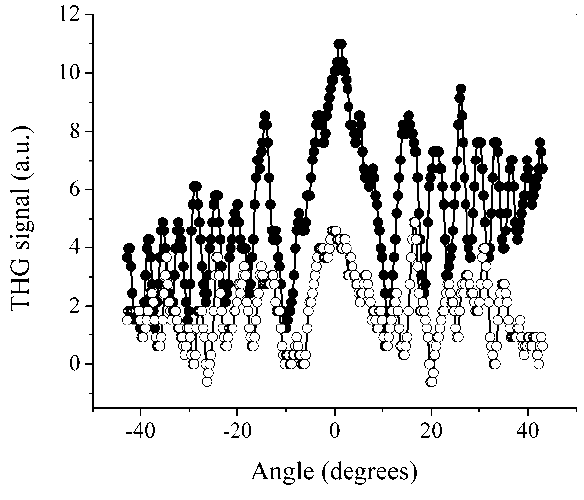
Figure 4. Third harmonic generation (THG) Maker-fringe pattern for a 92 nm-thin polystyrene polymer film of I doped with 30 wt. % of compound (filled circles) and for a 1 mm-thick substrate without a film deposited on it (open circles). The fundamental wavelength was 1200